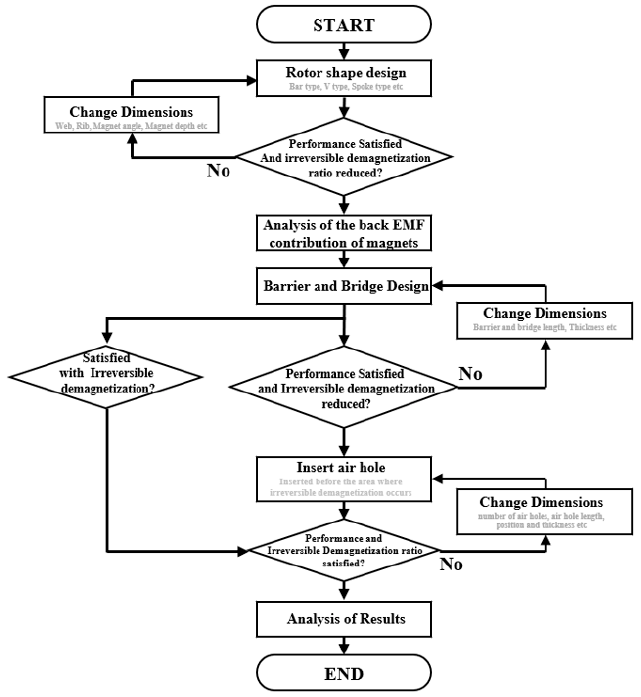
Figure 1. Rotor design process to minimize irreversible